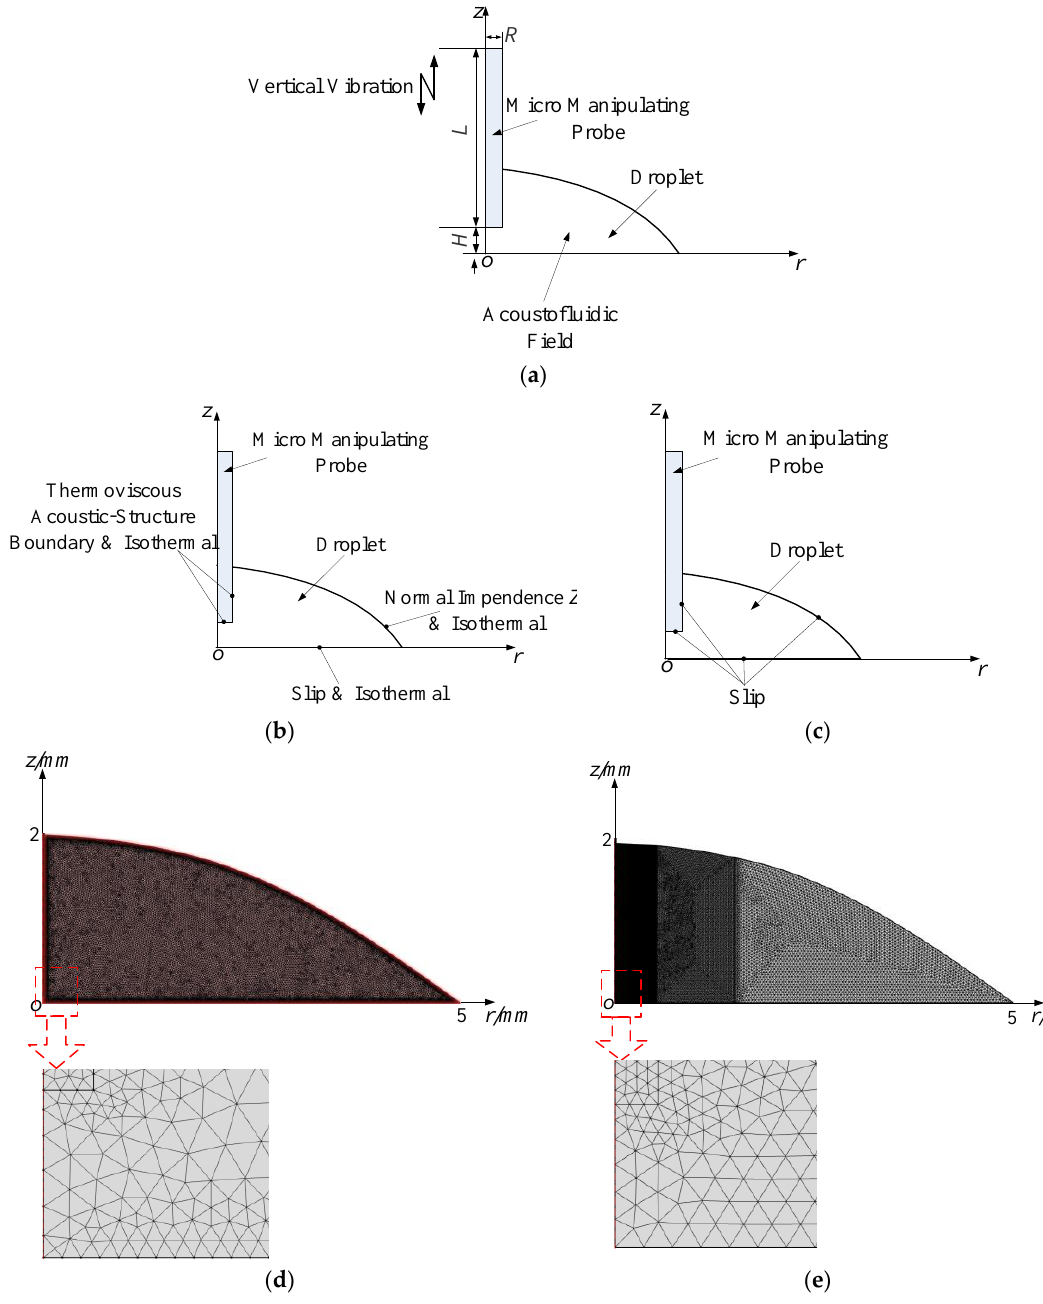
Figure 1. ( a ) 2D axisymmetric model of the acoustofluidic field in the ultrasonic probe-droplet-substrate system. ( b ) Boundary condition for the acoustic field in the ultrasonic probe-droplet-substrate system. ( c ) Boundary condition for the acoustic streaming field in the ultrasonic probe-droplet-substrate system. ( d ) Meshed model for the acoustofluidic field in the ultrasonic probe-droplet-substrate system under the simulation scheme of the PM. ( e ) Meshed model for the acoustofluidic field in the ultrasonic probe-droplet-substrate system under the simulation scheme of the